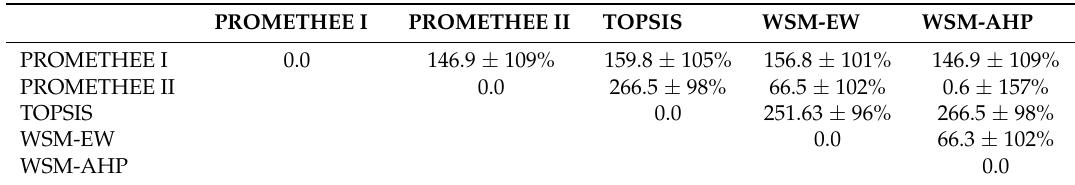
Table 5. Mean ranking differences and their relative standard